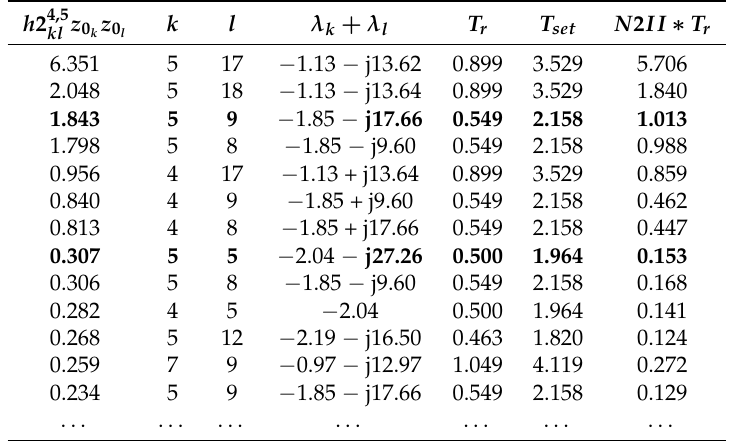
Table 5. NF-9310—Quantitative Measures of combination Modes for Fundamental Mode